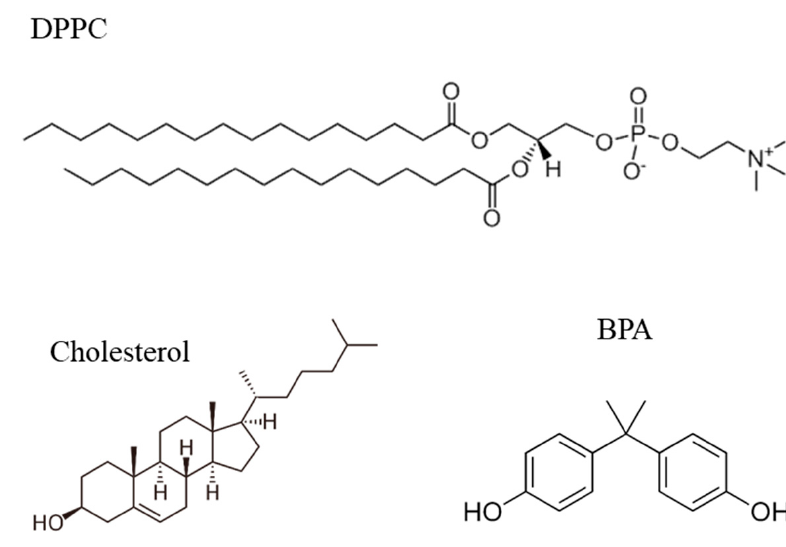
Figure 1. Chemical structures of DPPC, cholesterol, and BPA.